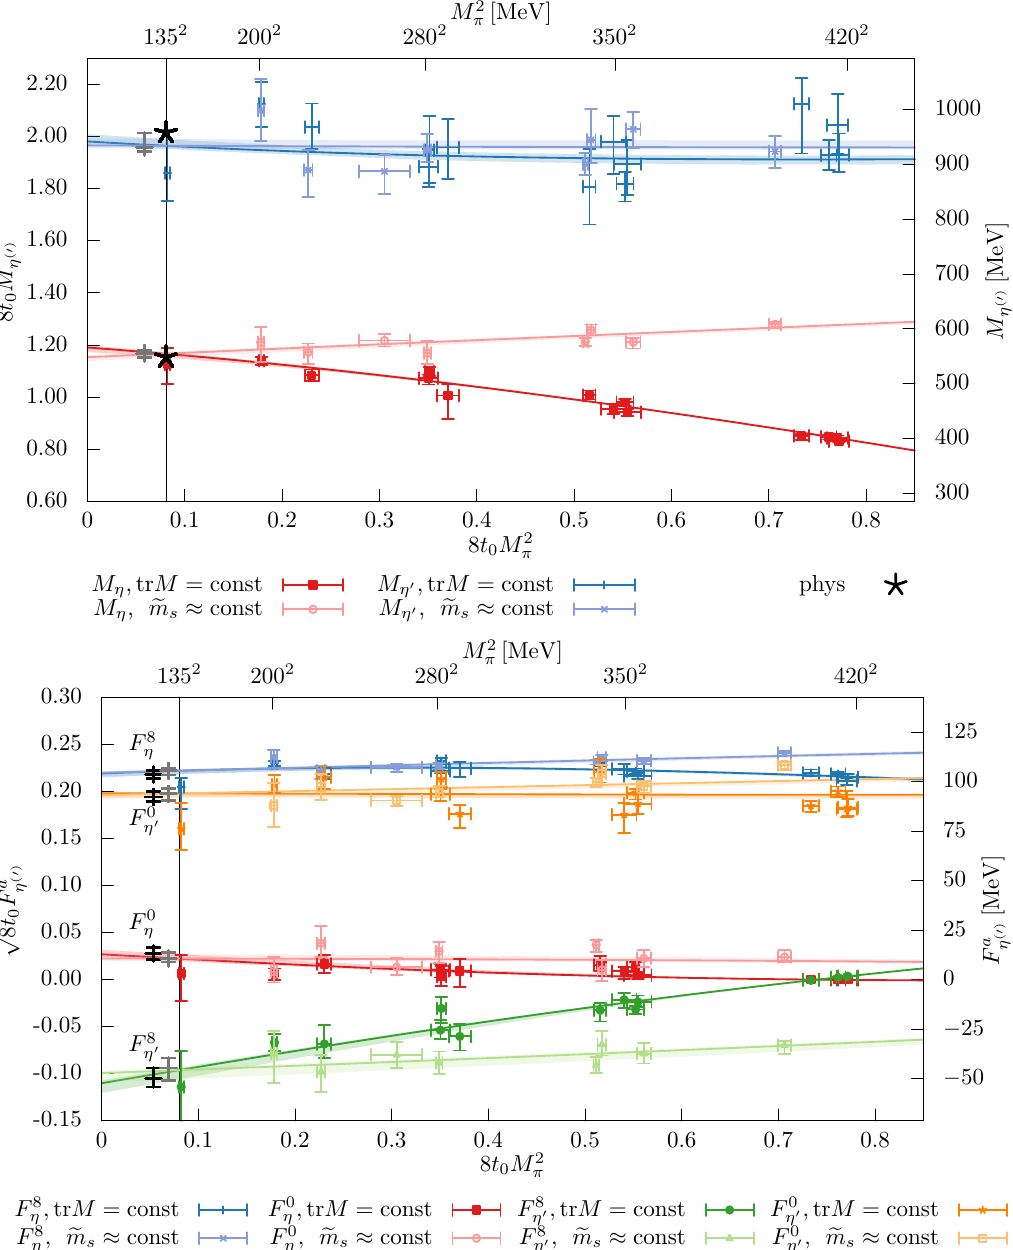
Figure 5. Simultaneous fit to the masses (top) and four decay constants (bottom) of the η and η 0 . The fit form incorporates the NLO large- N c ChPT expressions and the discretization terms corresponding to fit 7 in table 7. The points have been shifted to compensate for lattice spacing effects and lie along two trajectories leading to the physical point. The continuum fit functions are indicated by the lines and shaded regions (statistical errors only), where the darker and lighter colours correspond to the trajectories where the flavour average quark mass is held constant and the strange quark mass is kept constant, respectively. The grey and black error bars (shifted to the left of the physical pion mass for better visibility) are our final results, without priors (grey) and including the experimental η and η 0 masses (black stars) as priors (black, see section 5.7). All errors are added in